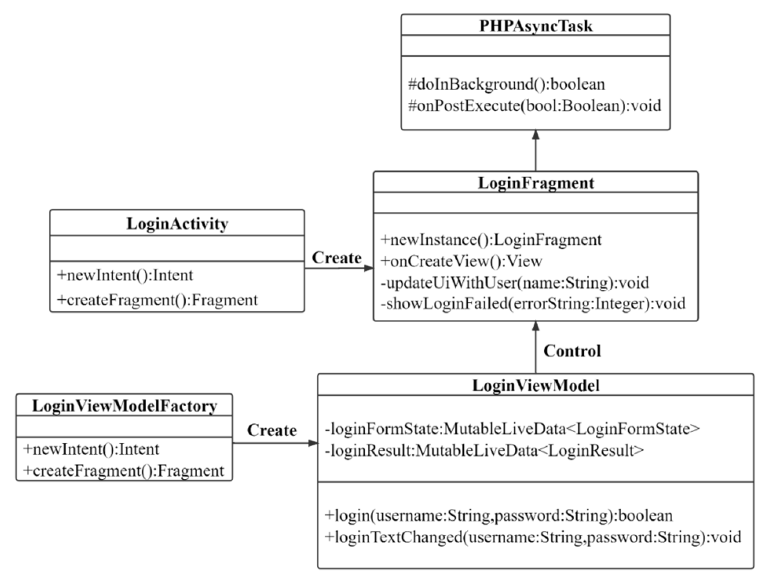
Figure 19. System login verification class diagram.